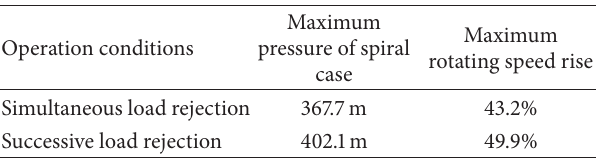
Table 2: Maximum pressure difference on breast wall under different